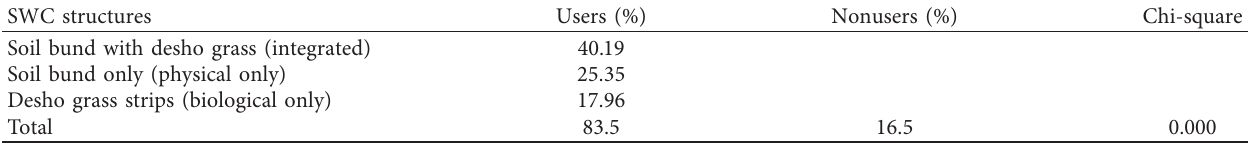
Table 4: Farmers’ choice of soil and water conservation measures in the study area.